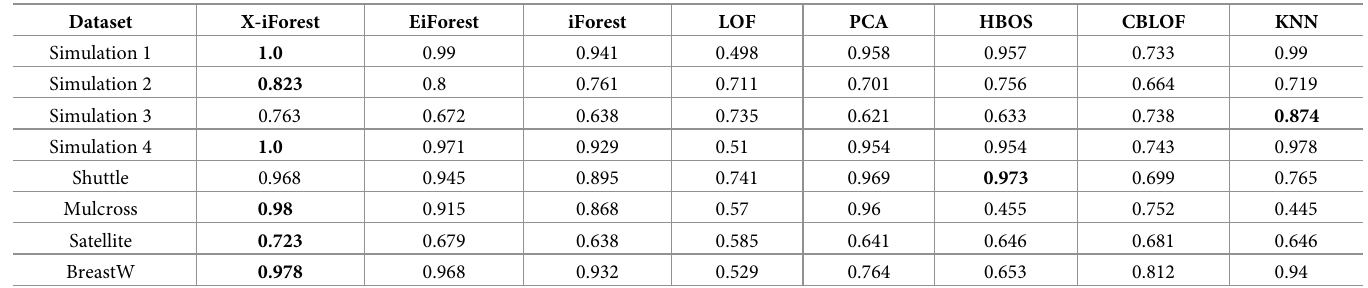
Table 2. AUC of X-iForest and other algorithms.